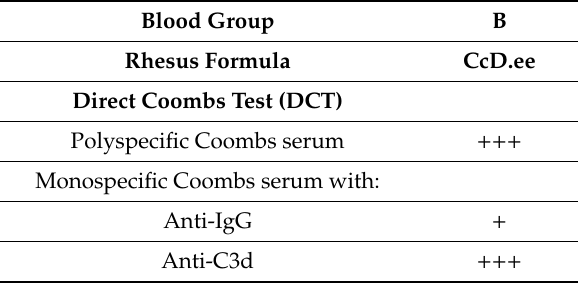
Table 3. Results obtained from haematological tests in whole blood of patient 2 during